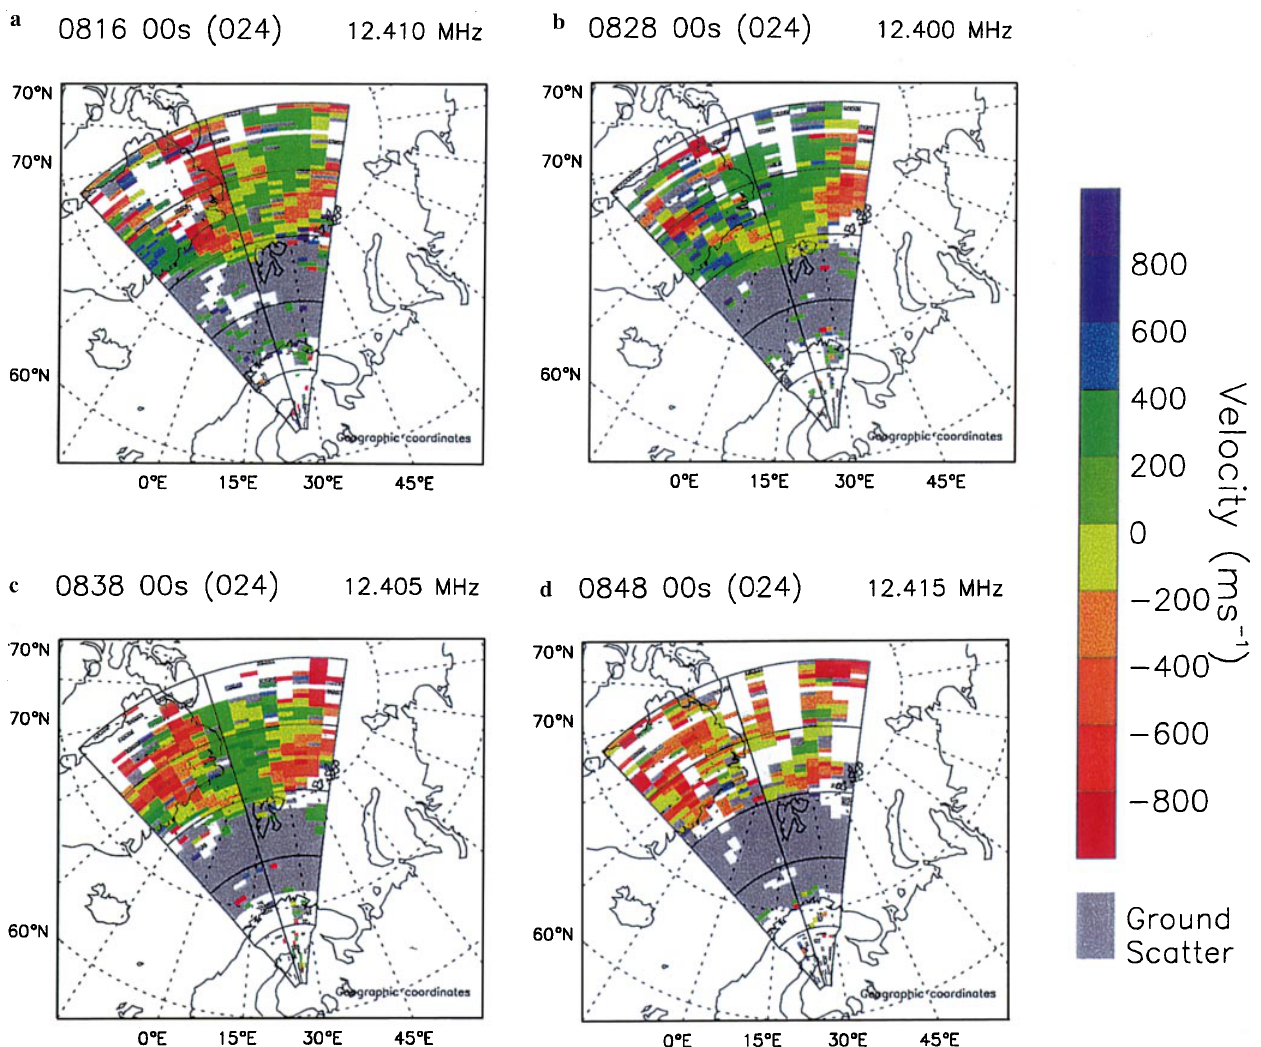
Fig. 4a–d. Plots of line-of-sight velocities measured by the CUTLASS Finland SuperDARN radar at the selected times shown on the morning of 24 January,